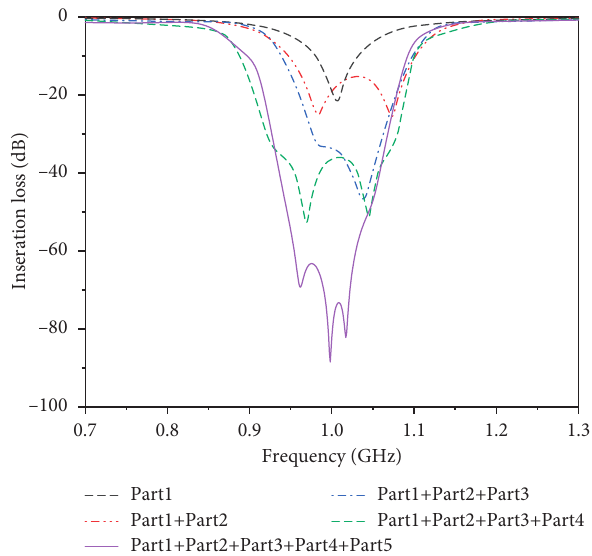
Figure 5: Filtering performance of the proposed bandstop